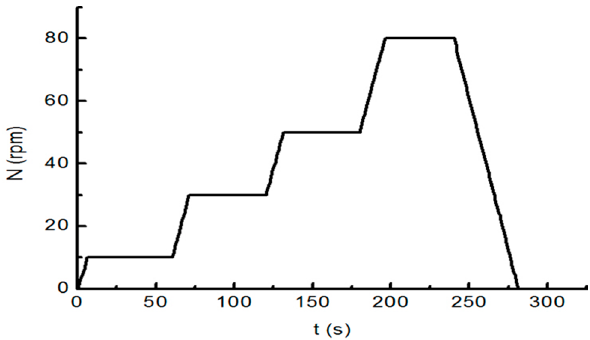
Figure 2. Speed-time (“ N-t “) control curve of the rheometer.